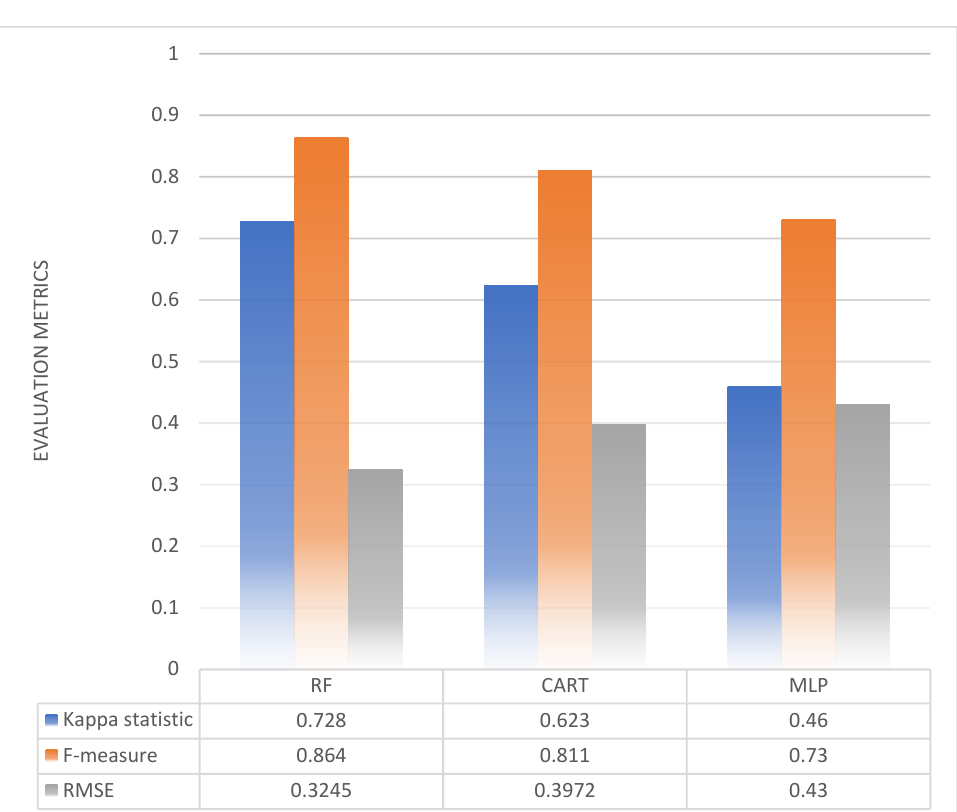
Figure 6. Classifiers’ Accuracies.